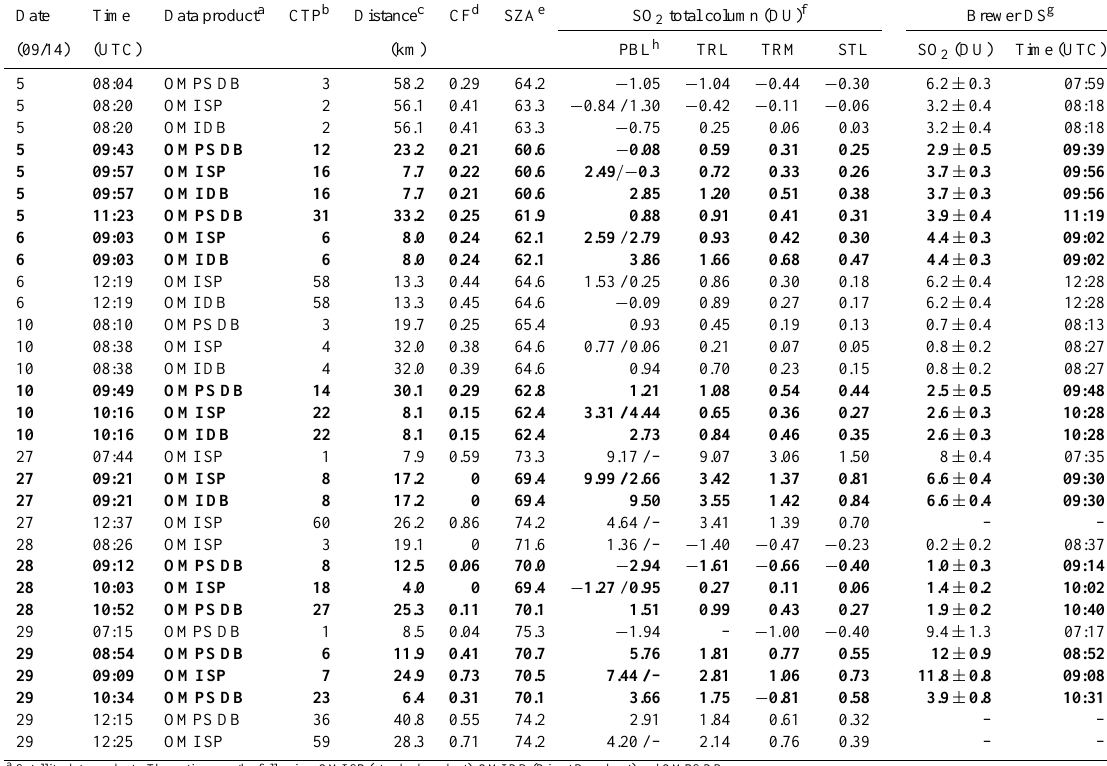
Table 2. Summary of the satellite overpasses at